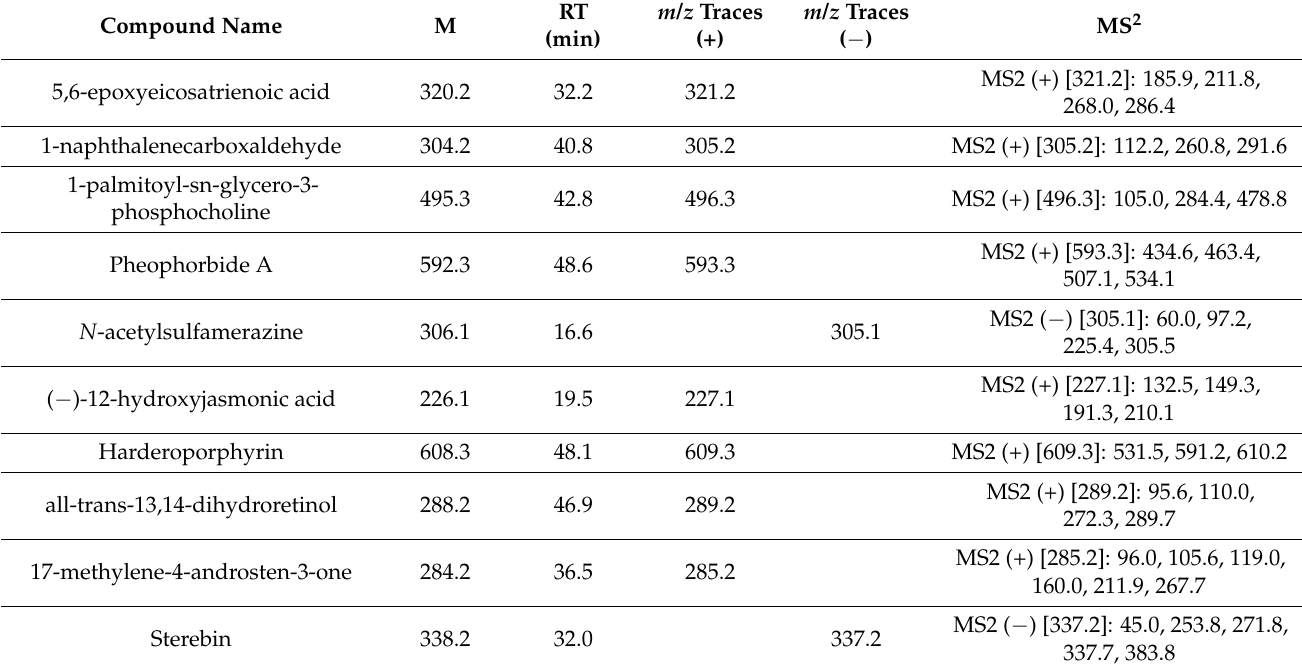
Table 1. Compounds identified in the MeOH extract of Lycopus maackianus using ultra-high- performance liquid chromatography–time-of-flight high-resolution mass spectrometry (UHPLC–